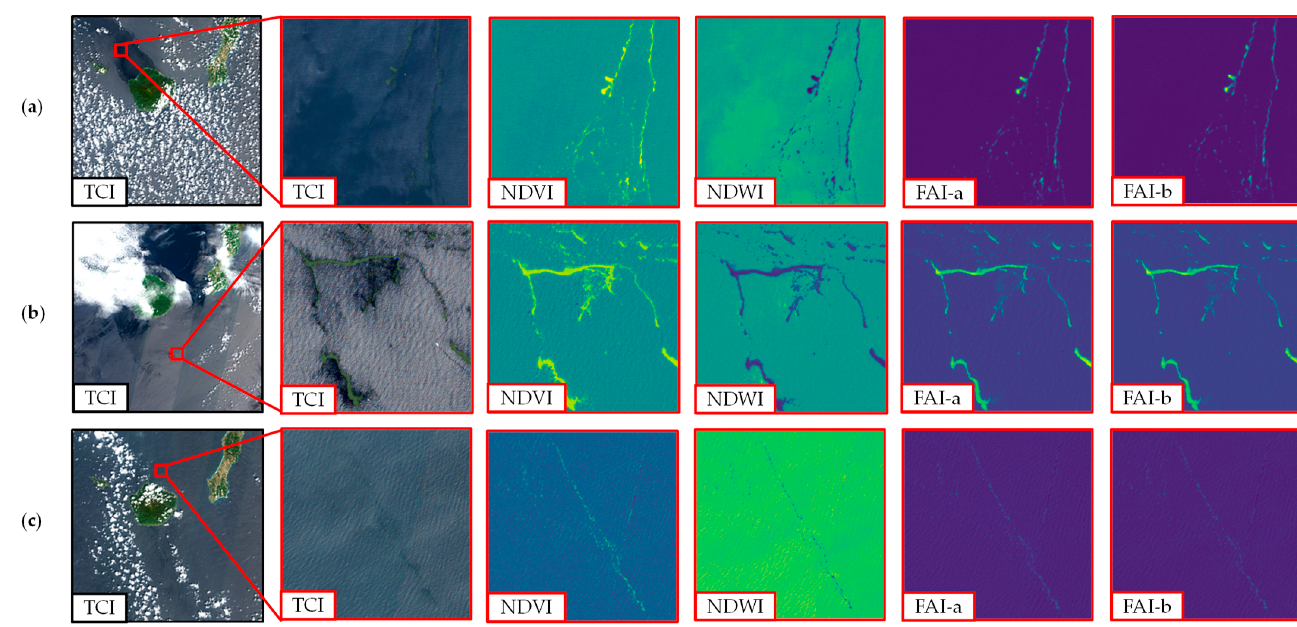
Figure 4. Illustration of floating macroalgae detection index on Sentinel-2 data tile (110 × 110 km 2 ) and the enlarged panes at second to fifth columns (4 × 4 km 2 ): ( a ) 27 March 2021, ( b ) 22 April 2019, ( c ) 28 March 2017. TCI, true-color image; NDVI, normalized difference vegetation index; NDWI, normalized difference water index; FAI-a, floating algae index with nearest-point interpolation; FAI-b, floating algae index with assumed zero reflectance. The details of these methods are found in the main text.